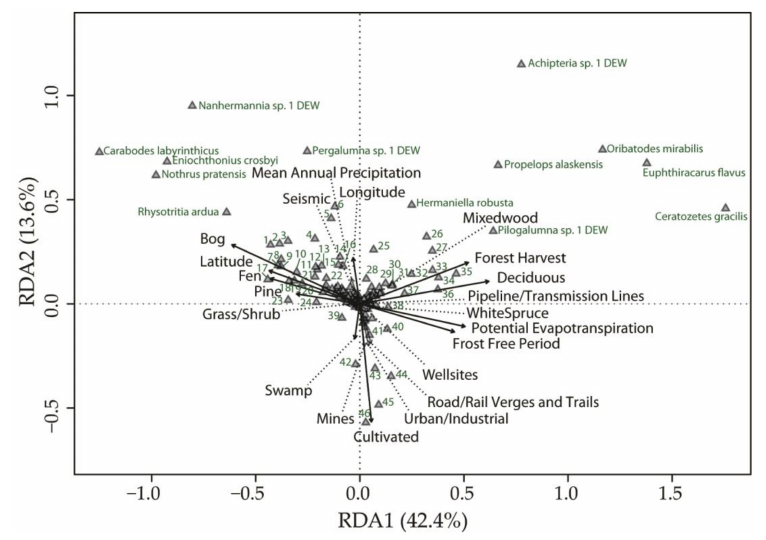
Figure 3. Redundancy analysis (RDA) plot of oribatid mite composition against 21 land cover and climate–space variables in the oil sands region of Alberta, Canada. The proportion of variance explained in each axis is shown. The triangles represent 201 oribatid mite species. The most vis- ible triangles are labelled with the species name or numbered as follows: 1. Cepheus sp. 1 DEW, 2. Allosuctobelba sp. 2 DEW, 3. Hoplophthiracarus illinoisensis , 4. Trhypochthonius tectorum , 5. Schelori- bates pallidulus , 6. Ceratoppia quadridentata arctica , 7. Scutozetes lanceolatus , 8. Hydrozetes sp. E RAN, 9. Roynortonella sp. 1 DEW, 10. Mainothrus badius , 11. Dentizetes ledensis , 12. Protoribates haughlandae ,